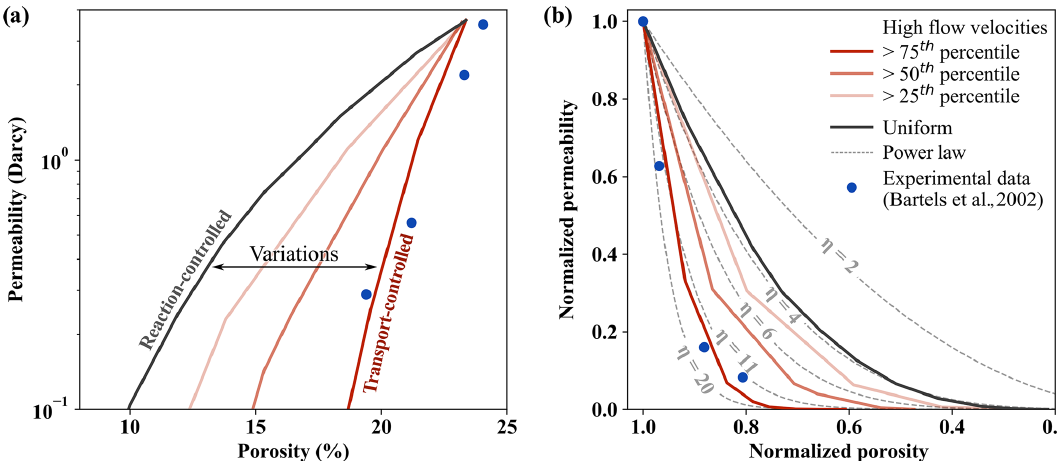
Figure 2. (a) Impact of anhydrite cement on permeability evolution observed during a core flooding experiment of Bartels et al. (2002), compared to the calculated porosity-permeability relations. (b) Normalised results compared to analytical relations by the power law with different exponents ( η ).